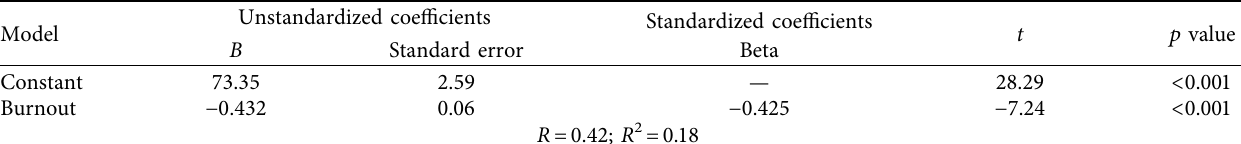
Table 4: The relationship between academic burnout and resilience.